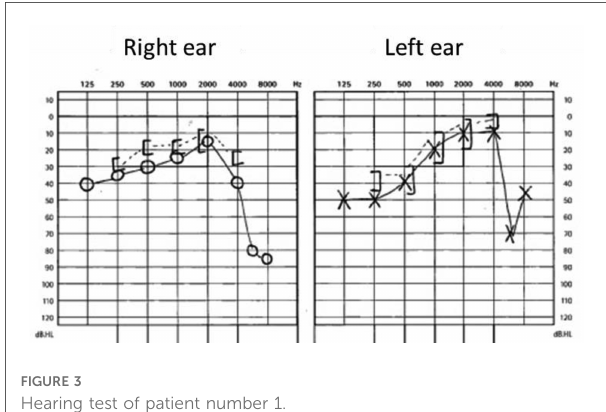
FIGURE 3 Hearing test of patient number